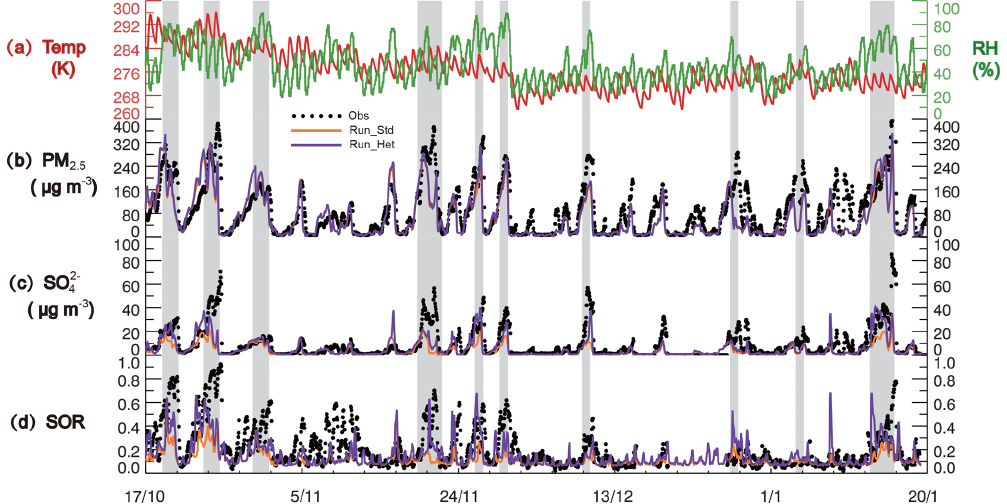
Figure 1. Time series of (a) GEOS-FP temperature (red line) and relative humidity (RH; green line), (b) PM 2 . 5 and (c) sulfate concentration, and (d) SOR at the surface in Beijing during the study period of 17 October 2014–20 January 2015. Hourly PM 2 . 5 , sulfate, and SOR observations (black dots) are compared with model results from Run_Std (orange line) and Run_Het (purple line). The gray-shaded bars represent 10 heavy pollution periods (HPPs) (PM 2 . 5 > 150µgm − 3 ) as defined in the text.